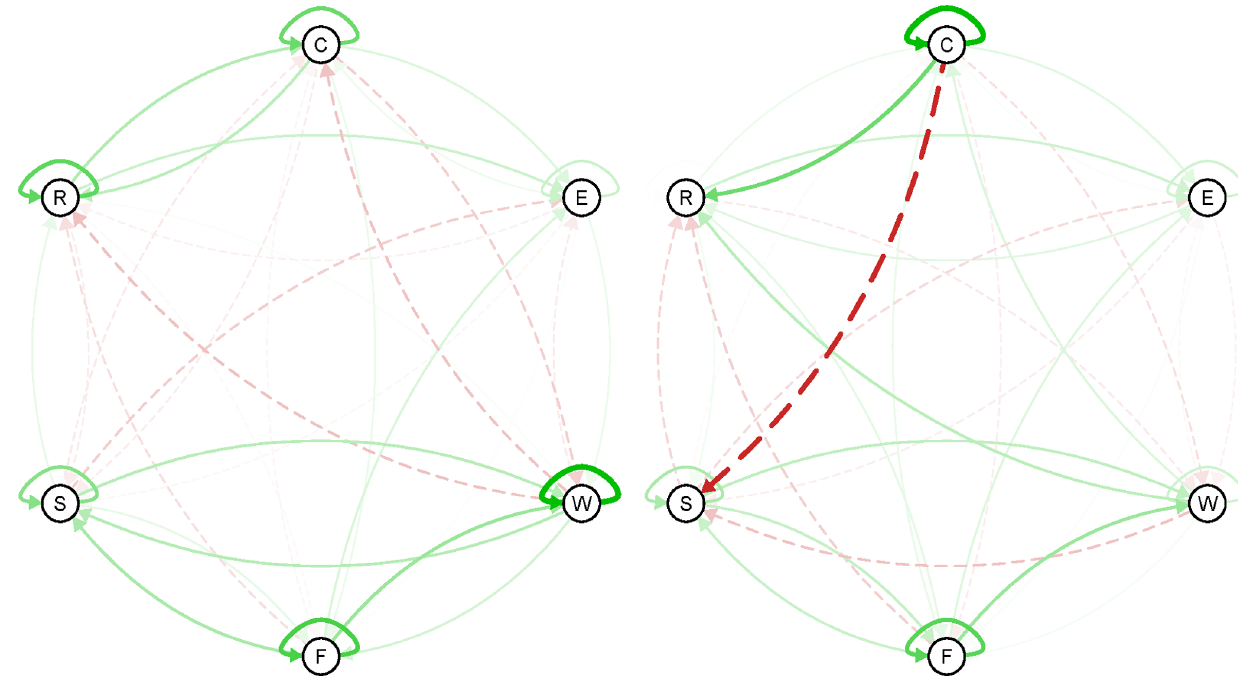
Figure 3. Individual networks (at baseline) of two different persons.